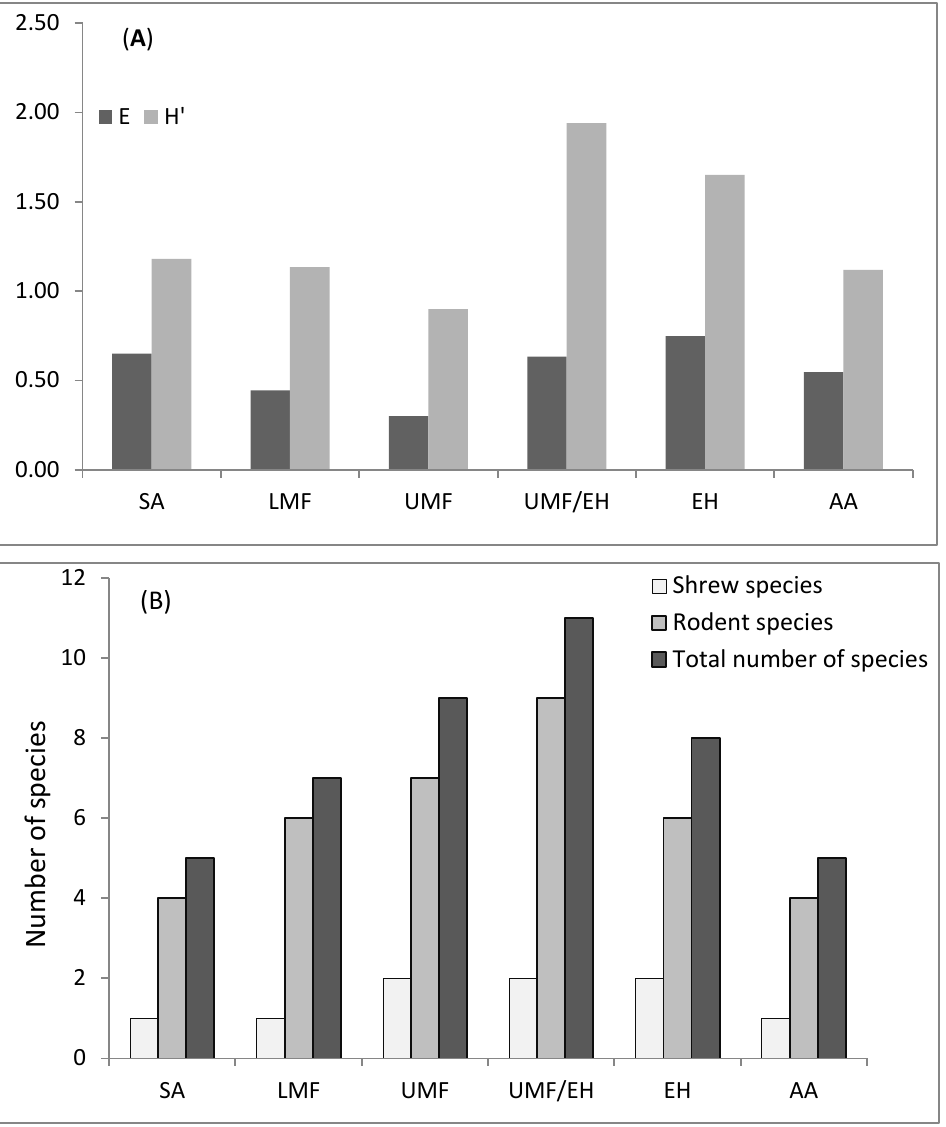
Figure 3. Diversity of small mammals across sites. ( A ) Species diversity evaluated with Shannon diversity index (H′) and evenness (E), and ( B ) species richness.